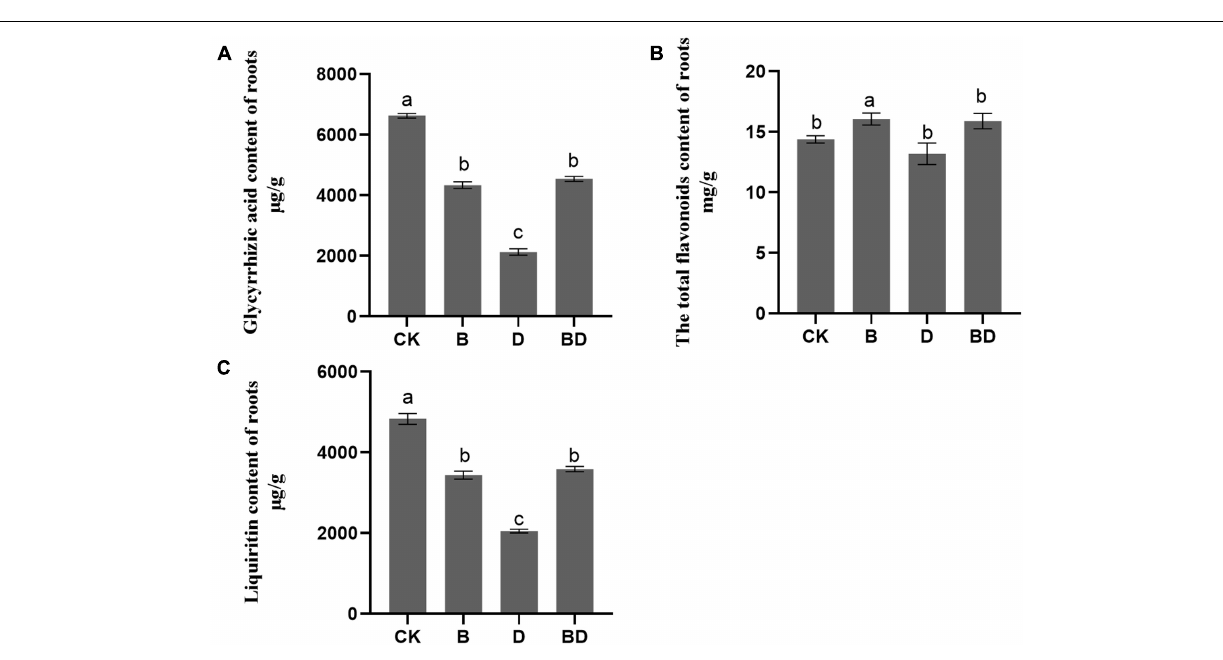
FIGURE 6 | Secondary metabolites of Glycyrrhiza uralensis . The (A) GA content, (B) total flavonoids content, and (C) LIQ content of roots ( F -value = 1,114.8, 465.8, 14.5). Bars are the mean ± SE ( n =